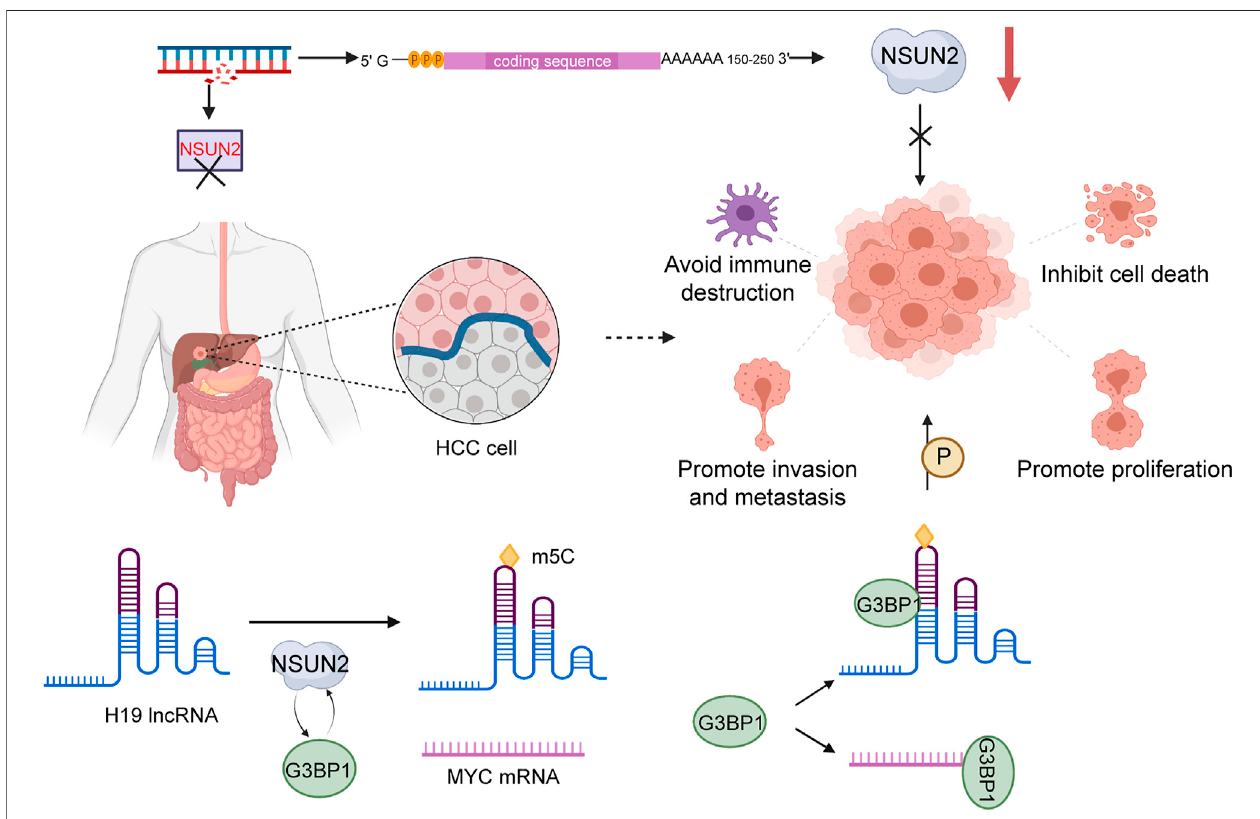
FIGURE2| TheroleofNSUN2inHCC.NSUN2catalyzesm5CmethylationinH19lncRNAandenhancesthemalignantpotentialofHCCbypromotingthebinding of G3BP1 and H19.